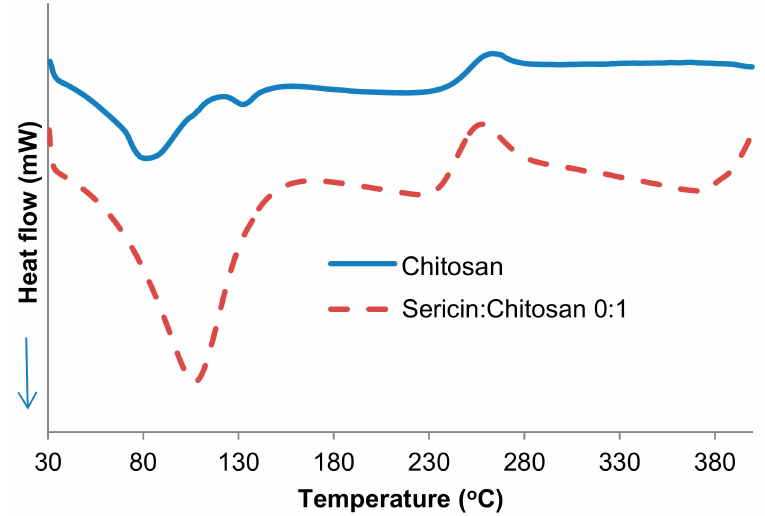
Figure 6. The DSC thermograms of the sericin-chitosan sca ff old (chitosan MW 15,000 g / mol) at a ratio of 1:1 and pure